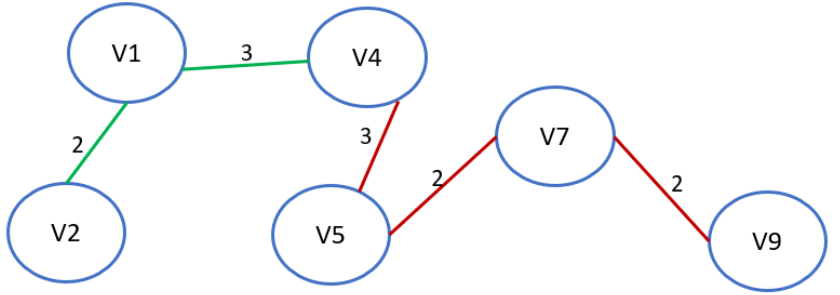
Figure 8. The route of transportation of products after the operation of the algorithm with preferences with a given tolerance coefficient of 10%.